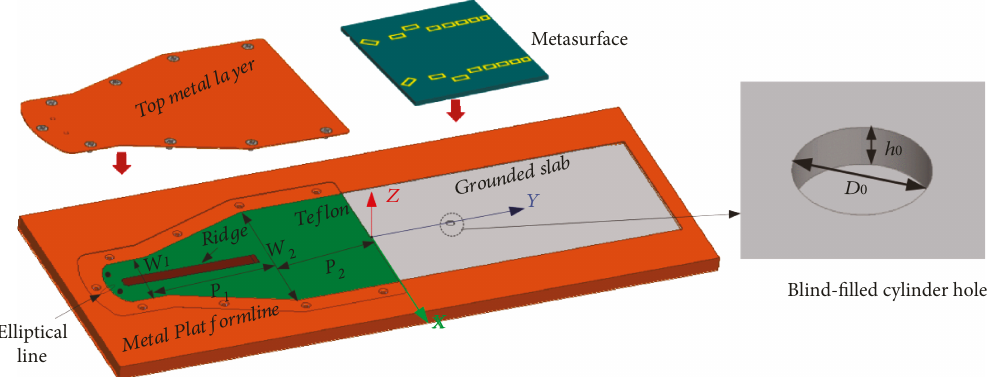
Figure 1: Wide bandwidth (BW) end- fi re surface wave printed on a large metallic platform [12].